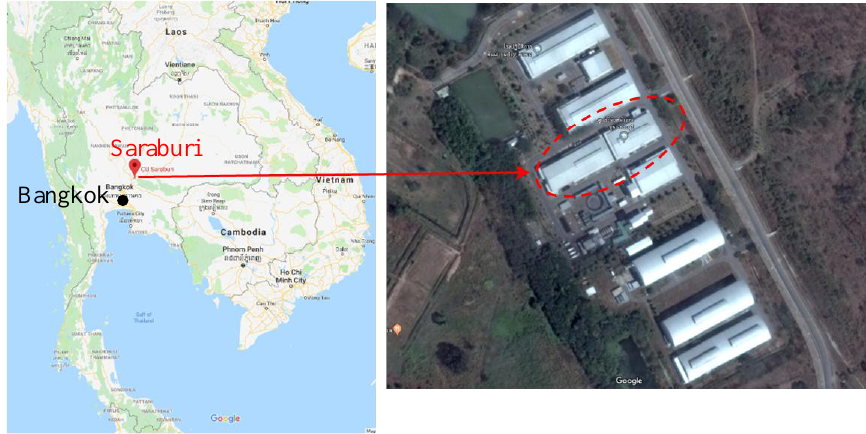
Figure 2. Location showing the installation site of ground-source heat pump (GSHP) systems at the